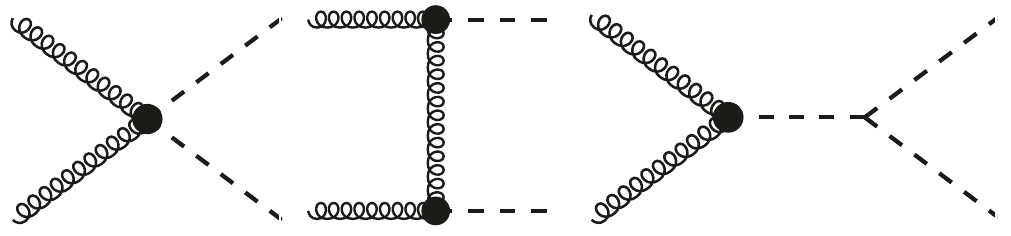
Figure 3 . Tree-level contributions to the gg ! HH amplitude in the e(cid:11)ective theory. The blob indicates the insertion of the operator O 1 . The left diagram is proportional to C HH , the one in the middle to C 2 and the right diagram, which contains the trilinear Higgs coupling (cid:21) , to C H . The H amplitudes corresponding to the three Feynman diagrams are denoted by A e(cid:11) and A e(cid:11) LO ; 1PR ;(cid:21) 6 =0